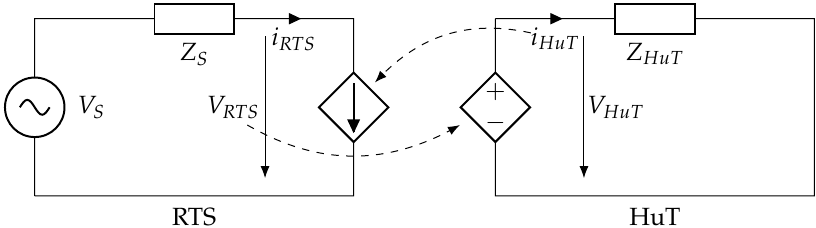
Figure 3. Voltage-type ITM interfacing algorithm for PHiL